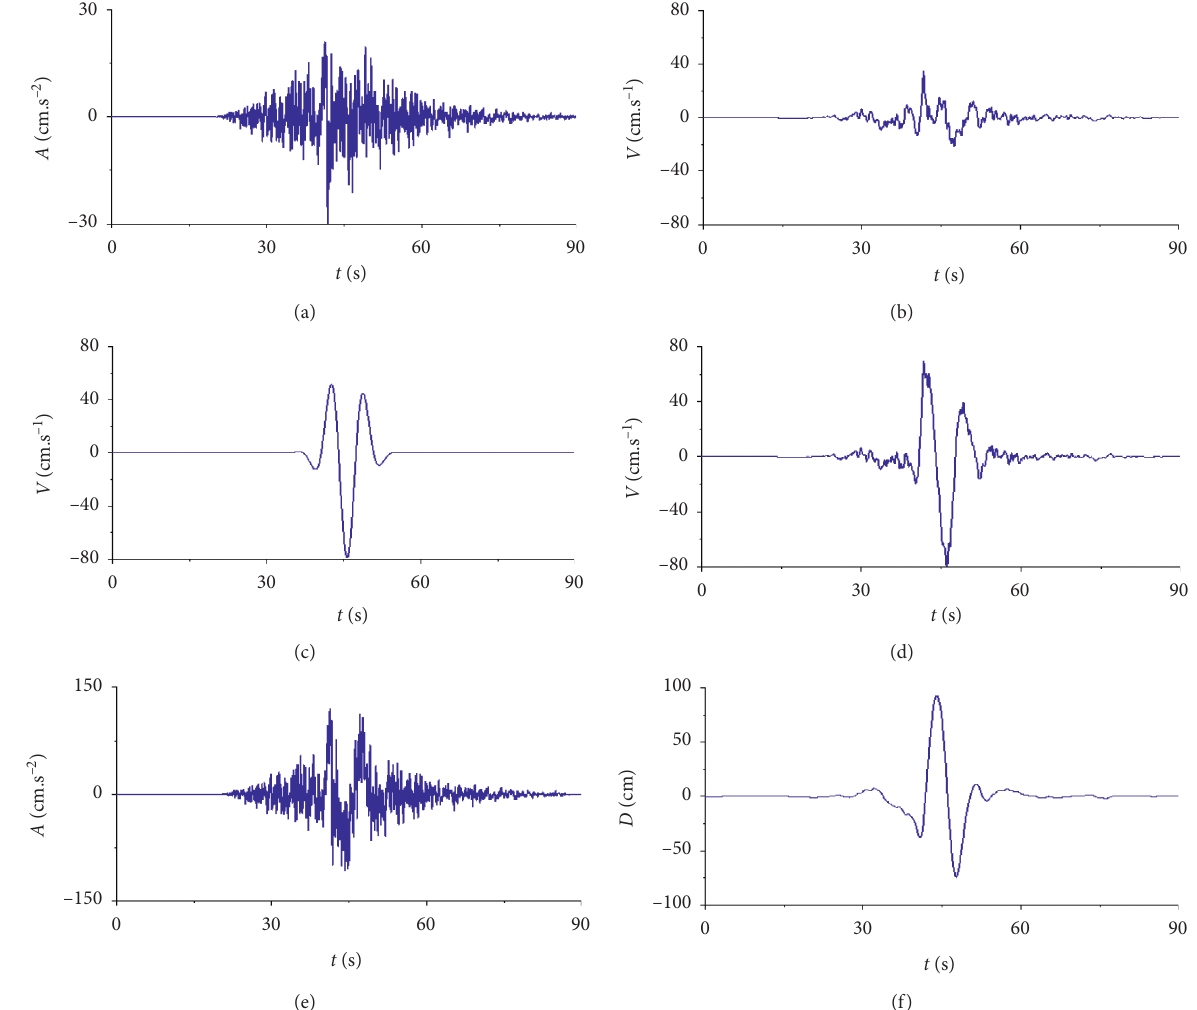
Figure 3: Artificial synthesizing results of the pulse-like ground motion with the rupture fault distance R � 15 km. (a). Acceleration history of high-frequency components. (b) Velocity history of high-frequency components. (c) Random velocity pulse. (d) Pulse-like velocity history. (e) Synthetic acceleration history. (f) Synthetic displacement history.